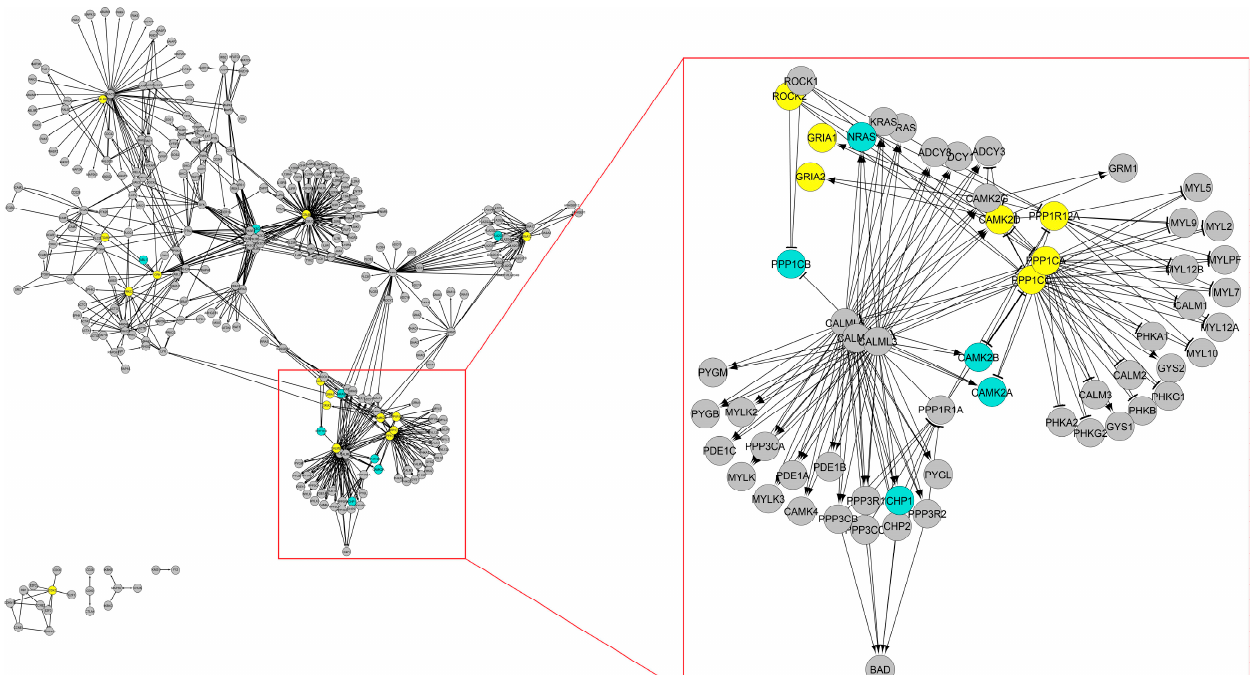
Figure 5. Pleiotropic genes in KEGG sub-network. Arrow-headed and bar-headed lines indicate the activation (positive) and the inhibition (negative) interactions, respectively. The grey circles belong to the non-observed genes. The blue circles represent confirmed pleiotropic genes from the HPO database. The yellow circles represent the novel candidate pleiotropic genes.